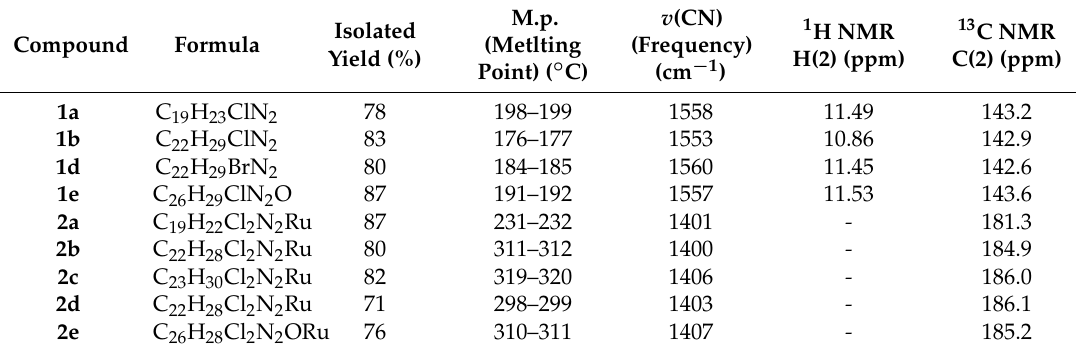
Table 1. Physical and spectroscopic properties of new compounds 1 and 2